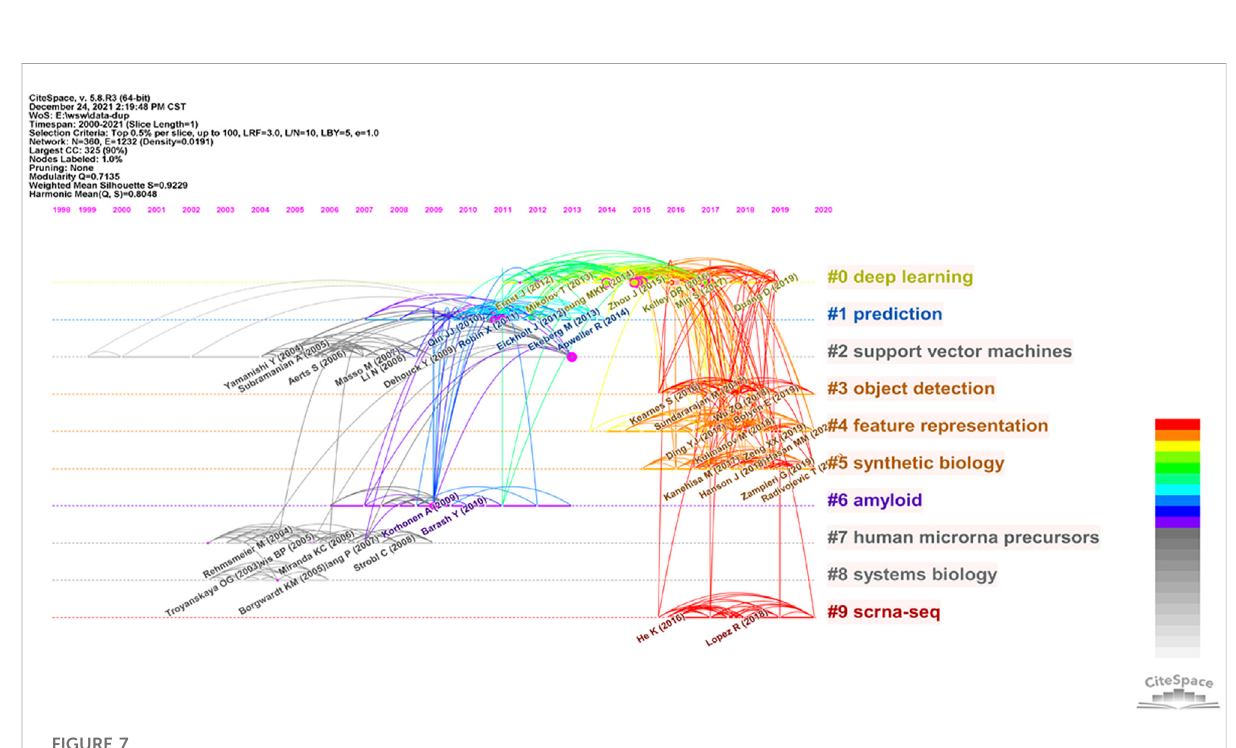
(Manavalan et al., 2019), cluster #5 “ synthetic biology ” (Wu et al., 2016), cluster #6 “ amyloid ” (Charoenkwan et al., 2021), cluster #7 “ human microRNA precursors ” (Wang et al., 2011), cluster #8 “ systems biology ” (Zou et al., 2015b), and cluster #9 “ scRNA-Seq (single cell RNA-Sequencing) ” (Arisdakessian et al., 2019).